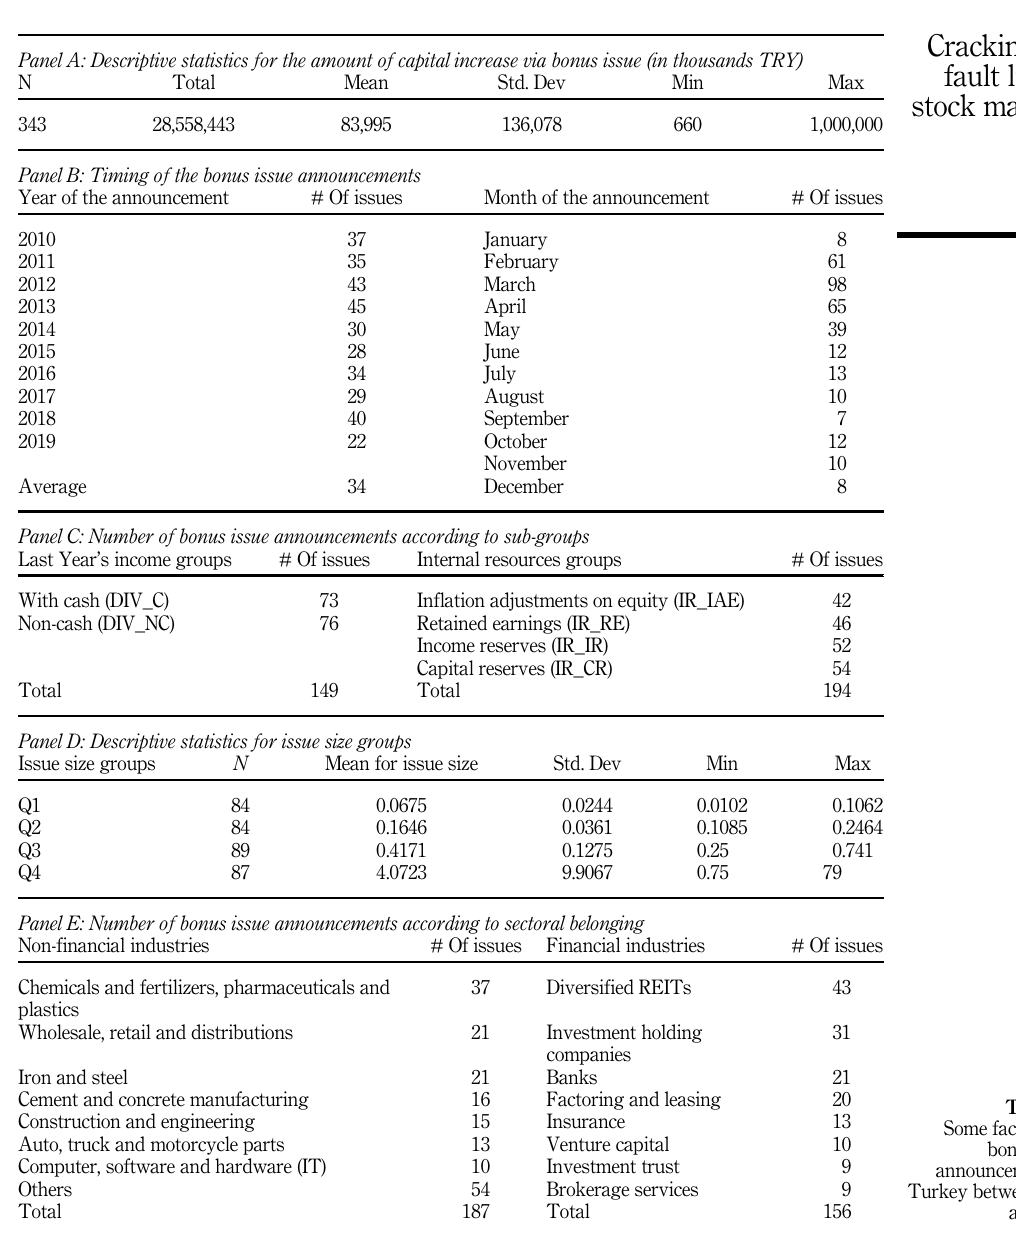
Panel A: Descriptive statistics for the amount of capital increase via bonus issue (in thousands TRY) N